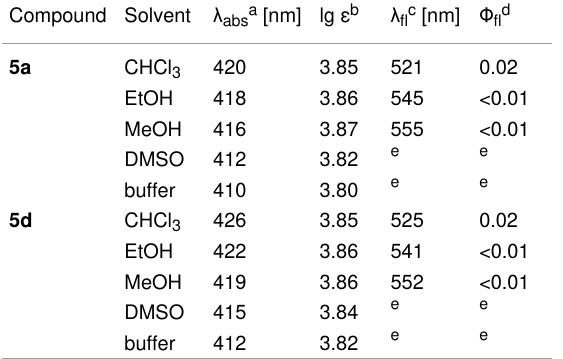
Table 1: Absorption and emission properties of representative 10- O - aryl-substituted berberine derivatives 5a and 5d in different solvents. Compound Solvent λ absa [nm] lg ε b